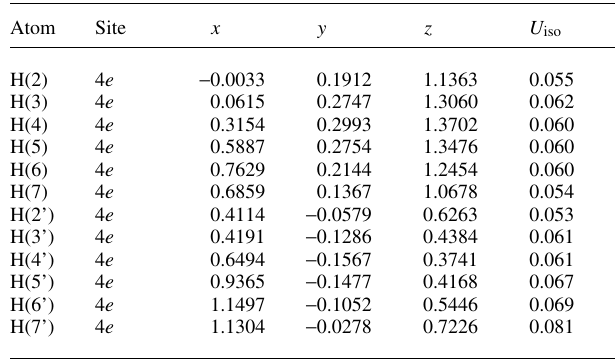
Table 2. Atomic coordinates and displacement parameters (in Å 2 ) .